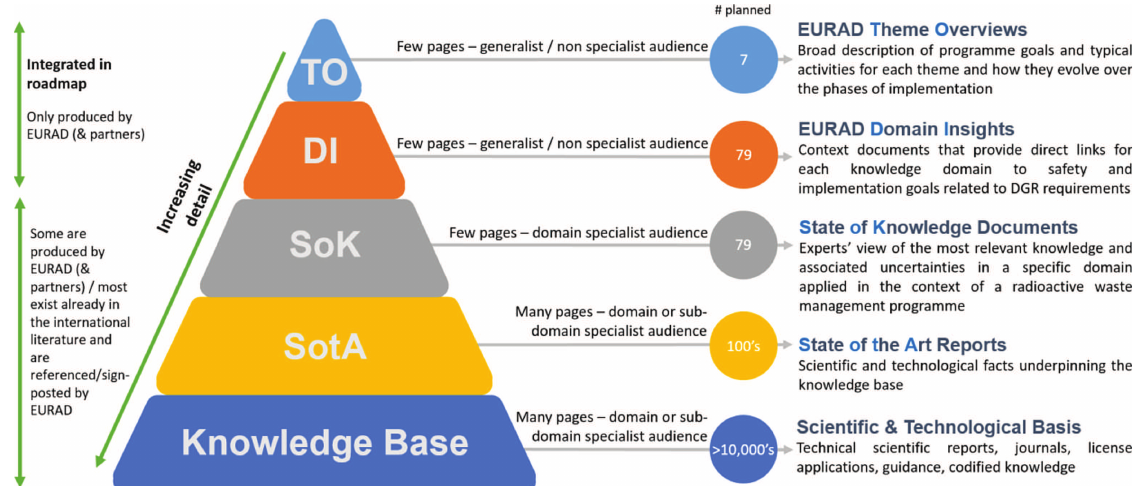
Fig. 2. Hierachy of documents that are relevant for the work of WP11 SoK in the EURAD KM